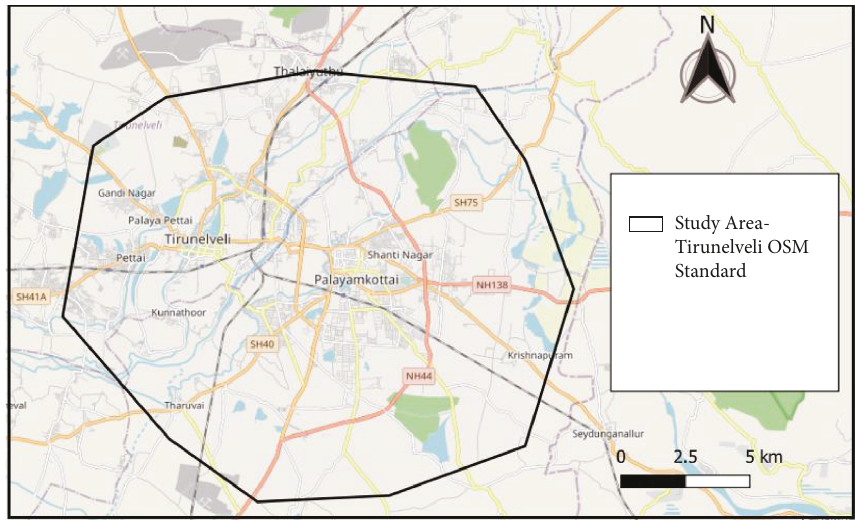
Figure 1: Location of study area.